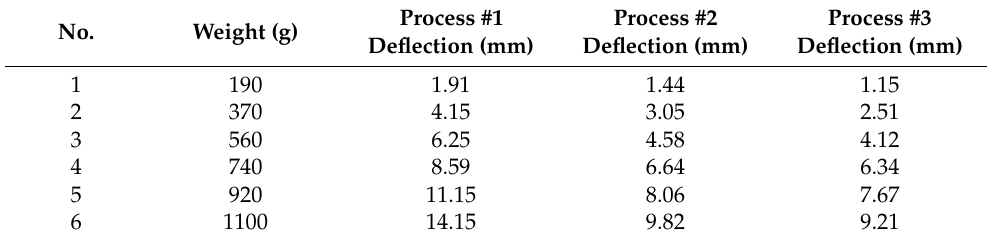
Table 5. Deflection as a function of the weight of the CFRP bar produced in each